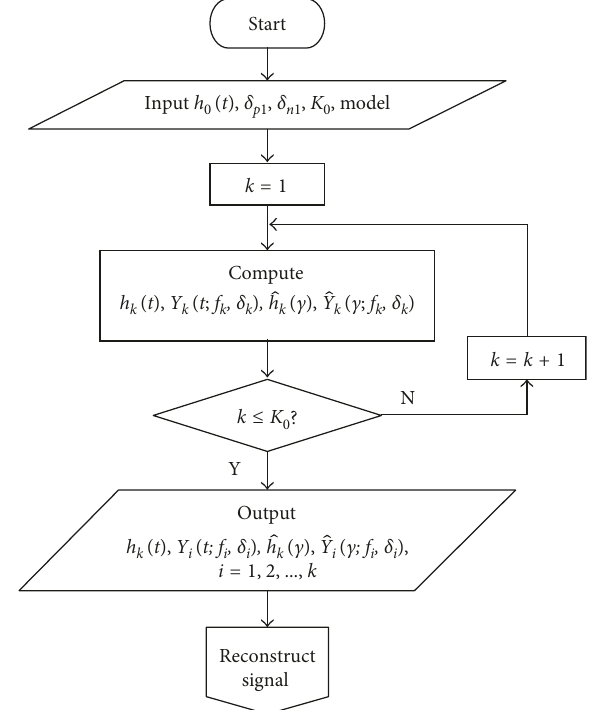
Figure 4: The flow chart for analysing a